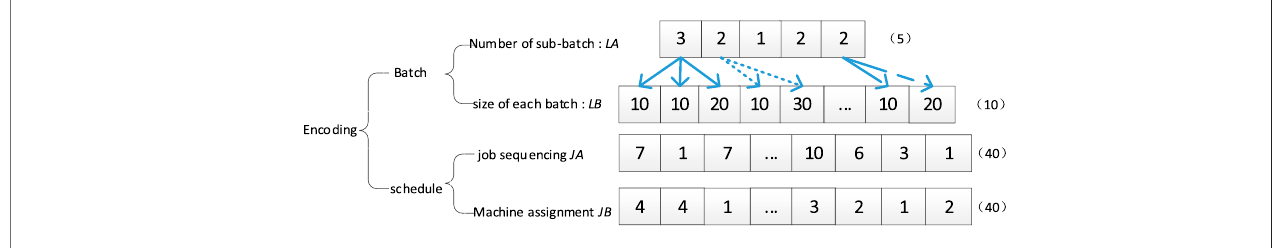
FIGURE 3 | Encoding